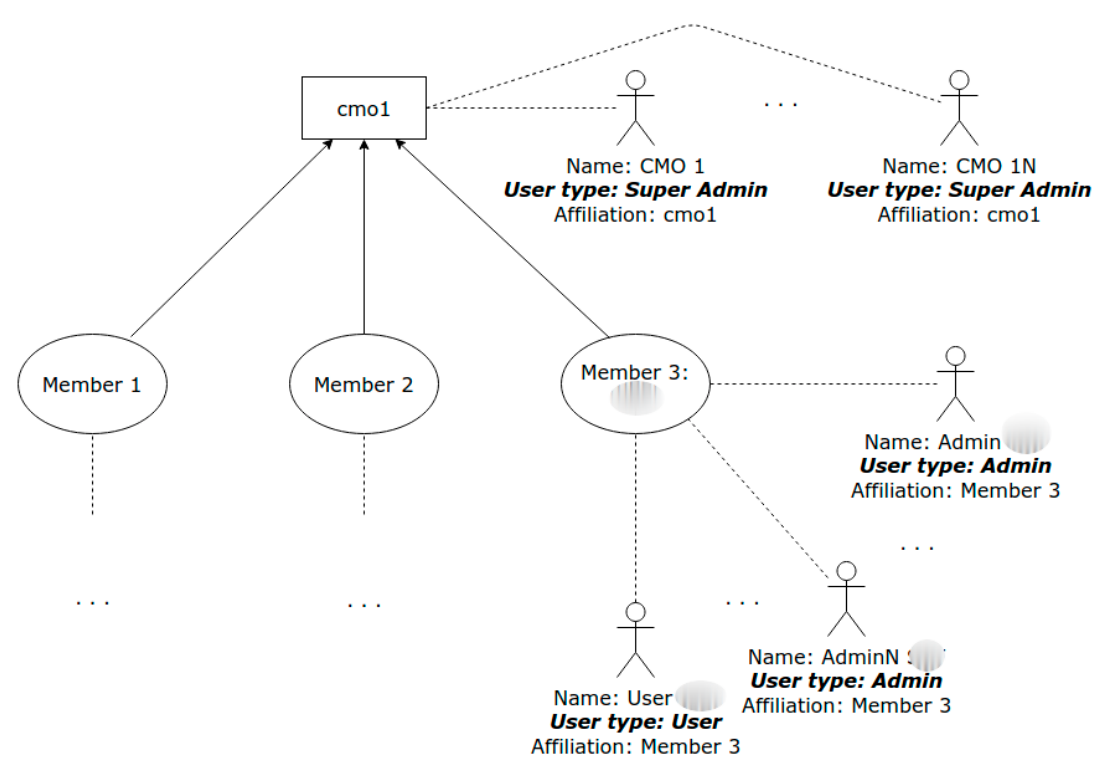
Figure 4. The user hierarchy with relations to business actors.